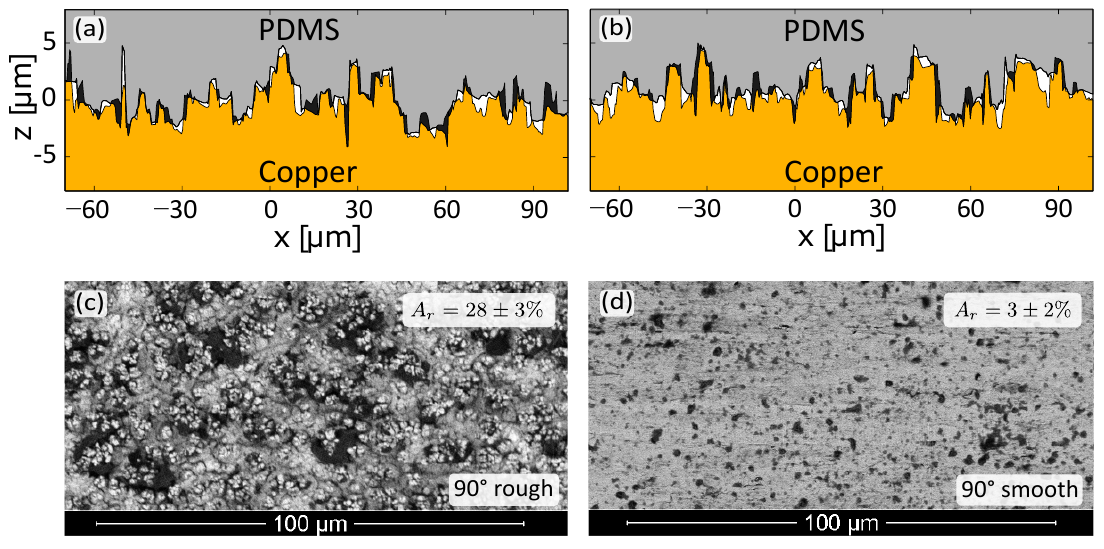
Figure 3. ( a , b ) reconstructed cross-sections at two locations from the obtained Copper-PDMS residual surface profile; ( c , d ) BSE images of the PDMS residue on the copper surfaces for the 90 ◦ peel test; A r values are averaged over 10